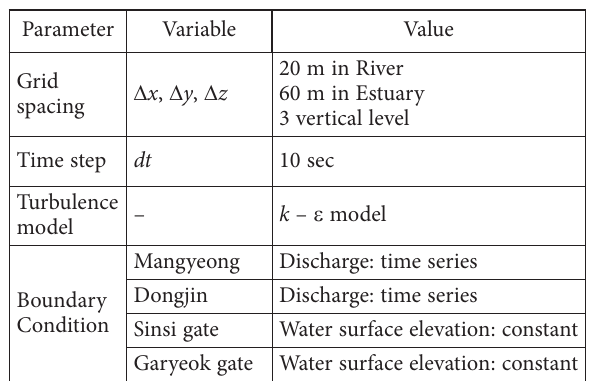
Table 4. The numerical conditions for verifying the ecological